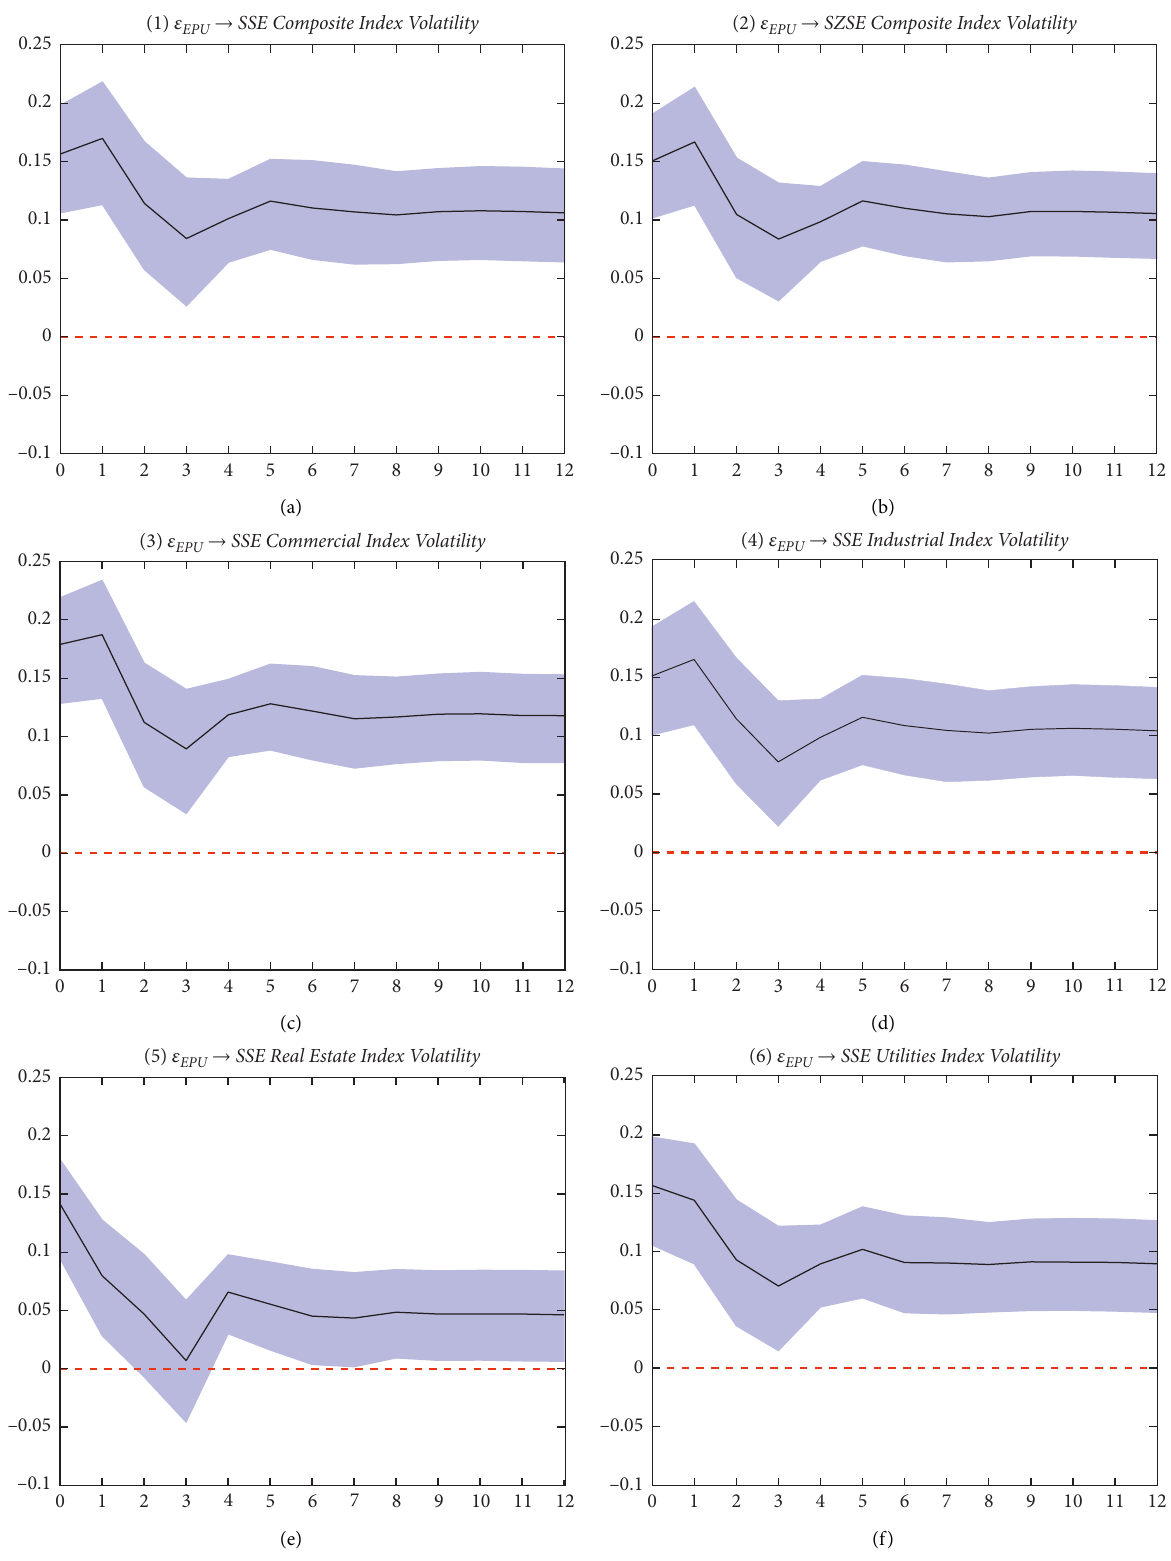
Figure 8: Cumulative impulse response of stock market volatility to fiscal EPU (FEPU) shocks. Note: the solid black lines denote the median impulse response. The light-colored region represents 68% of error bands. Each period is a